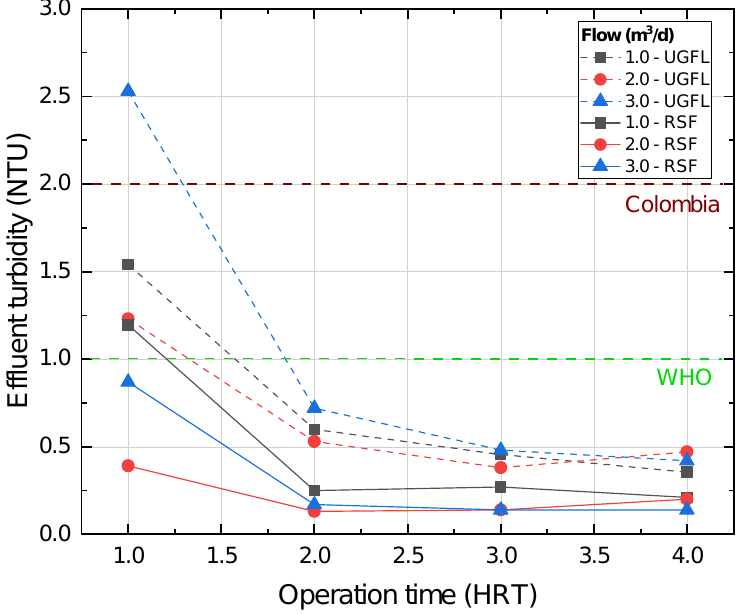
Figure 11. Results for the evaluation of the increase in operating flow (water type II and PACl). After an operating time of 2 HRT, it was observed that the turbidity in the effluent of the UGFL was similar for the three flows evaluated, reaching values between 0.36 and 0.47 NTU at the end of the test. Similar behaviour was observed in the RSF, achieving effluent turbidity between 0.14 and 0.21 NTU for an operating time of 4 HRT for the three flows. For the tests and for all operating times evaluated, the SDWTS effluent reported values for apparent colour ( ≤ 10 CU, for both flows), pH (2.0 m 3 /d: 6.68 ±